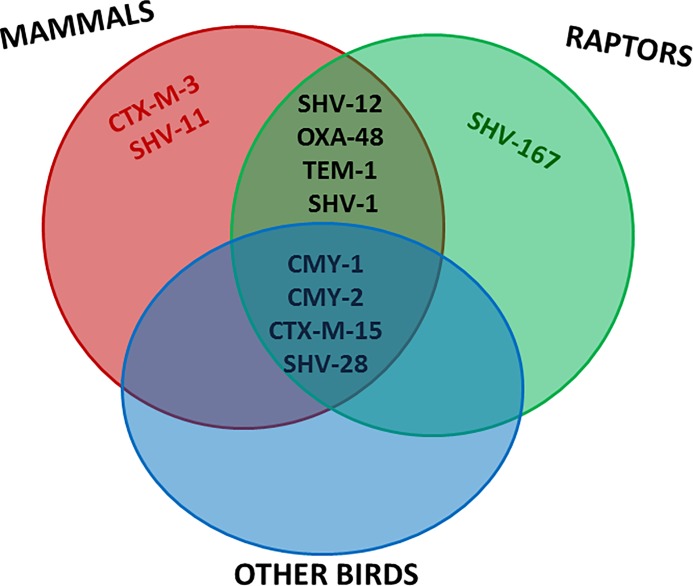
Venn diagram showing the distribution of AMR genes in the different animal groups encountered in this study.